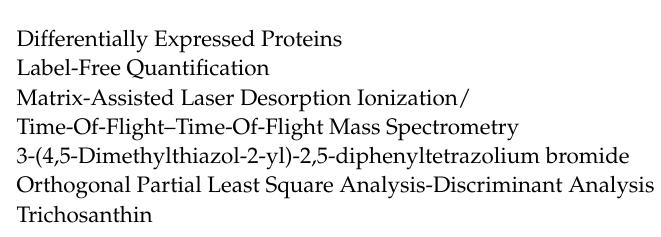
Supplementary Materials: Table S1: Full record of the MTT experiment; Table S2: Detailed protein identification and quantitation results, Figure S1: MTT result overview, Figure S2: 2DE graph, (A) first repetition; (B) second repetition 250 ug, pH3-10 NL, 18 cm, silver stained. DEPs were selected